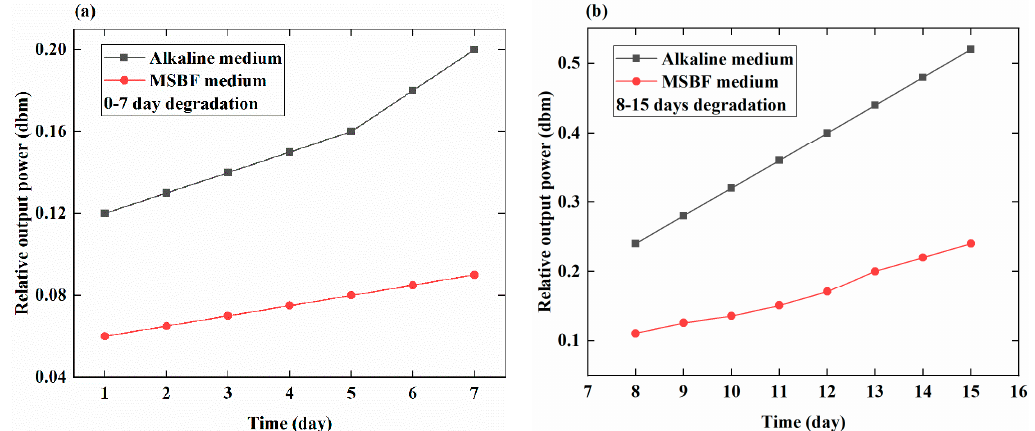
Figure 5. Comparison of the relative output power at different times in alkaline (PH = 12) and MSBF media (PH = 7.4). ( a ) Degradation during 0–7 days; ( b ) degradation during 7–15 days.